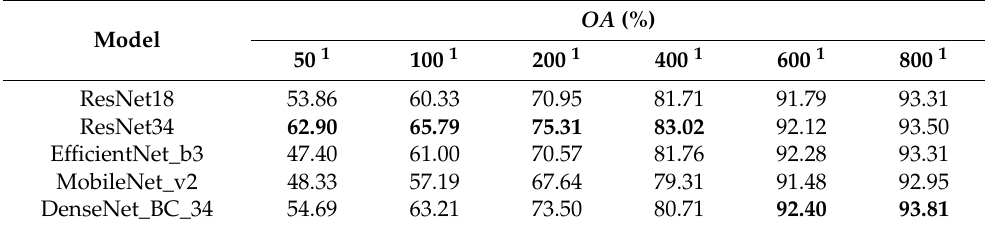
Table 1. The results of different models with different amounts of training